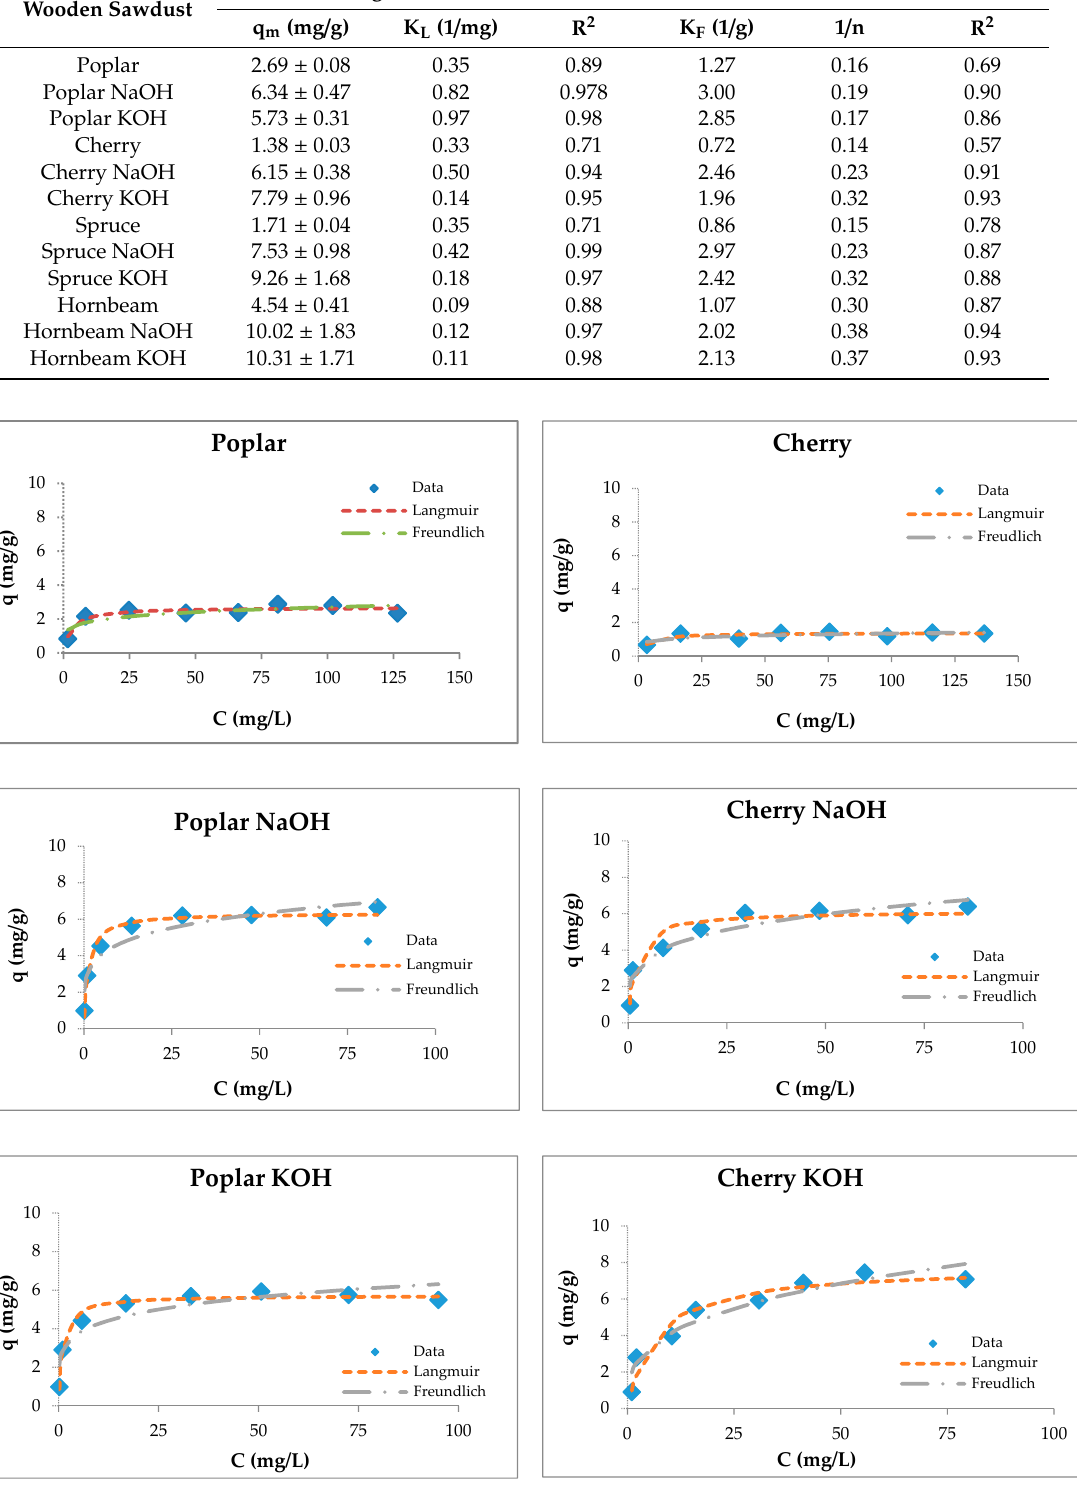
Table 3. Langmuir constants for zinc sorption by wooden sawdust.